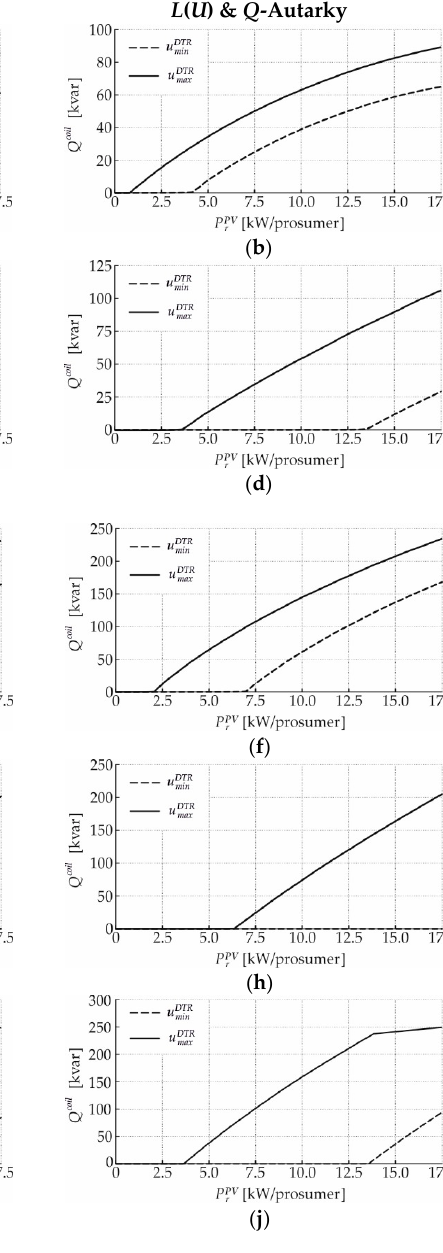
( a , b ) Long OL; ( c , d ) Short OL; ( e , f ) Long C; ( g , h ) Short C; ( i , j ) Branched